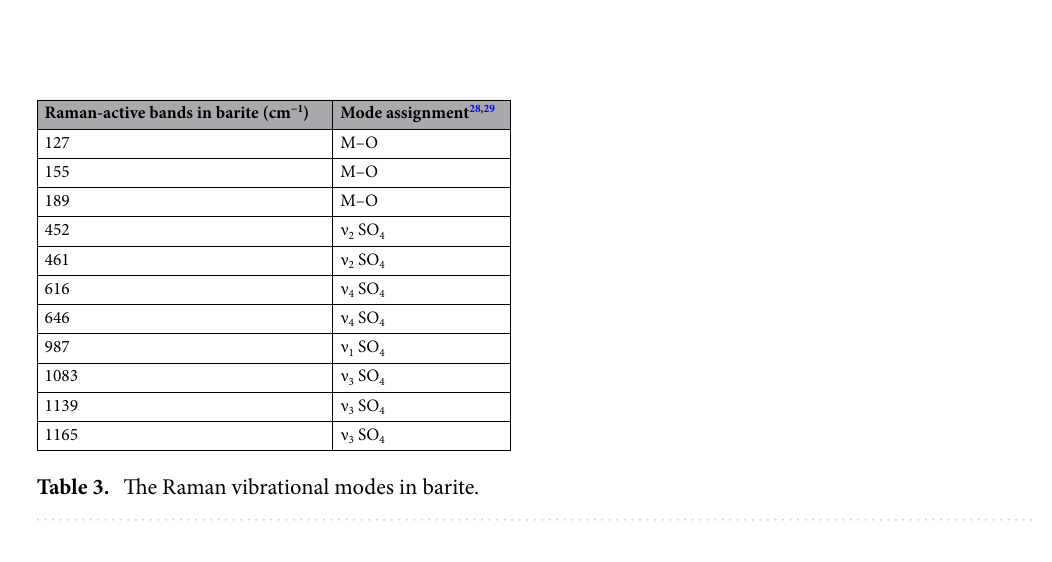
Figure 9. Microphotos and Raman spectra collected in the various regions of barite crystal: red and blue lines correspond to spectra collected in microprobe analytical points 14 and 9, respectively (vide Table 2). The inset shows the variations in the intensity of the Raman bands at 461 and 452 cm −1 recorded for crystal domains slightly differing in Sr and Ba content.